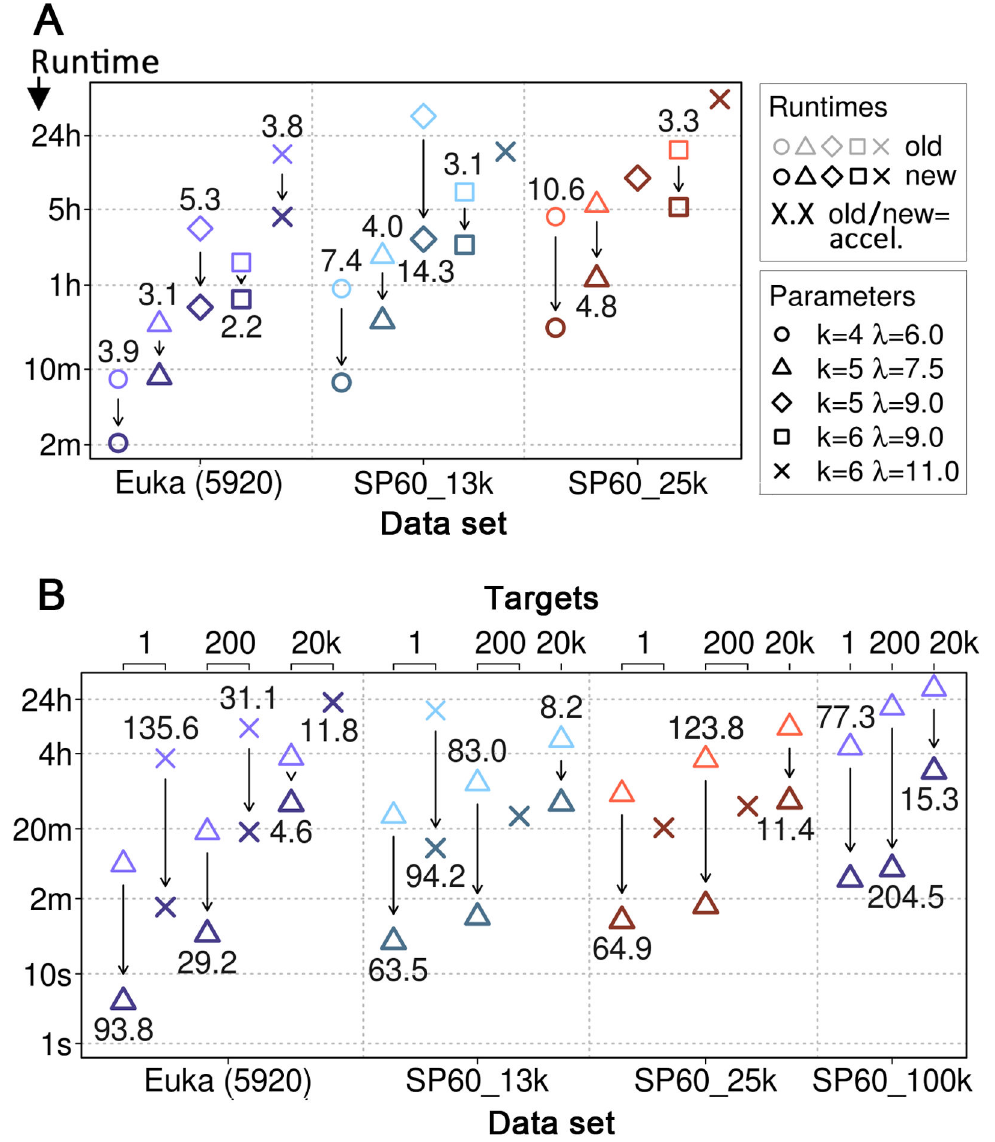
Figure 2. Speed measurements. Each arrow compares the runtime of the original implementation (upper symbol) to the new implementation (lower symbol). The symbol type indicates the parameter combination. The number above or below an arrow is the acceleration (original runtime divided by new runtime). All runtimes are wall-clock times of single processes. We did not perform an experiment if it was clear that it would take longer than 24 hours. ( A ) Kernel matrix calculations . In this subfigure we compare kernel matrix creation runtimes. Data sets correspond to subsets of a redundancy reduced Swiss-Prot database with 5920 (‘Euka (5920)’), 12,500 (‘SP60_13k’), 25,000 (‘SP60_25k’) and 100,000 (‘SP60_100k’) samples, respectively. The SP60_100k experiment (“k=5, σ=7.5”) for which we used 100 CPUs in parallel took 40 minutes and is not shown. ( B ) Prediction of new targets . This subfigure displays the runtimes for predicting three sets of targets (1, 200 and 20,000 profiles; axis on top) using models created with the training data sets (‘Euka (5920)’ to ‘SP60_100k’; axis on bottom). doi: